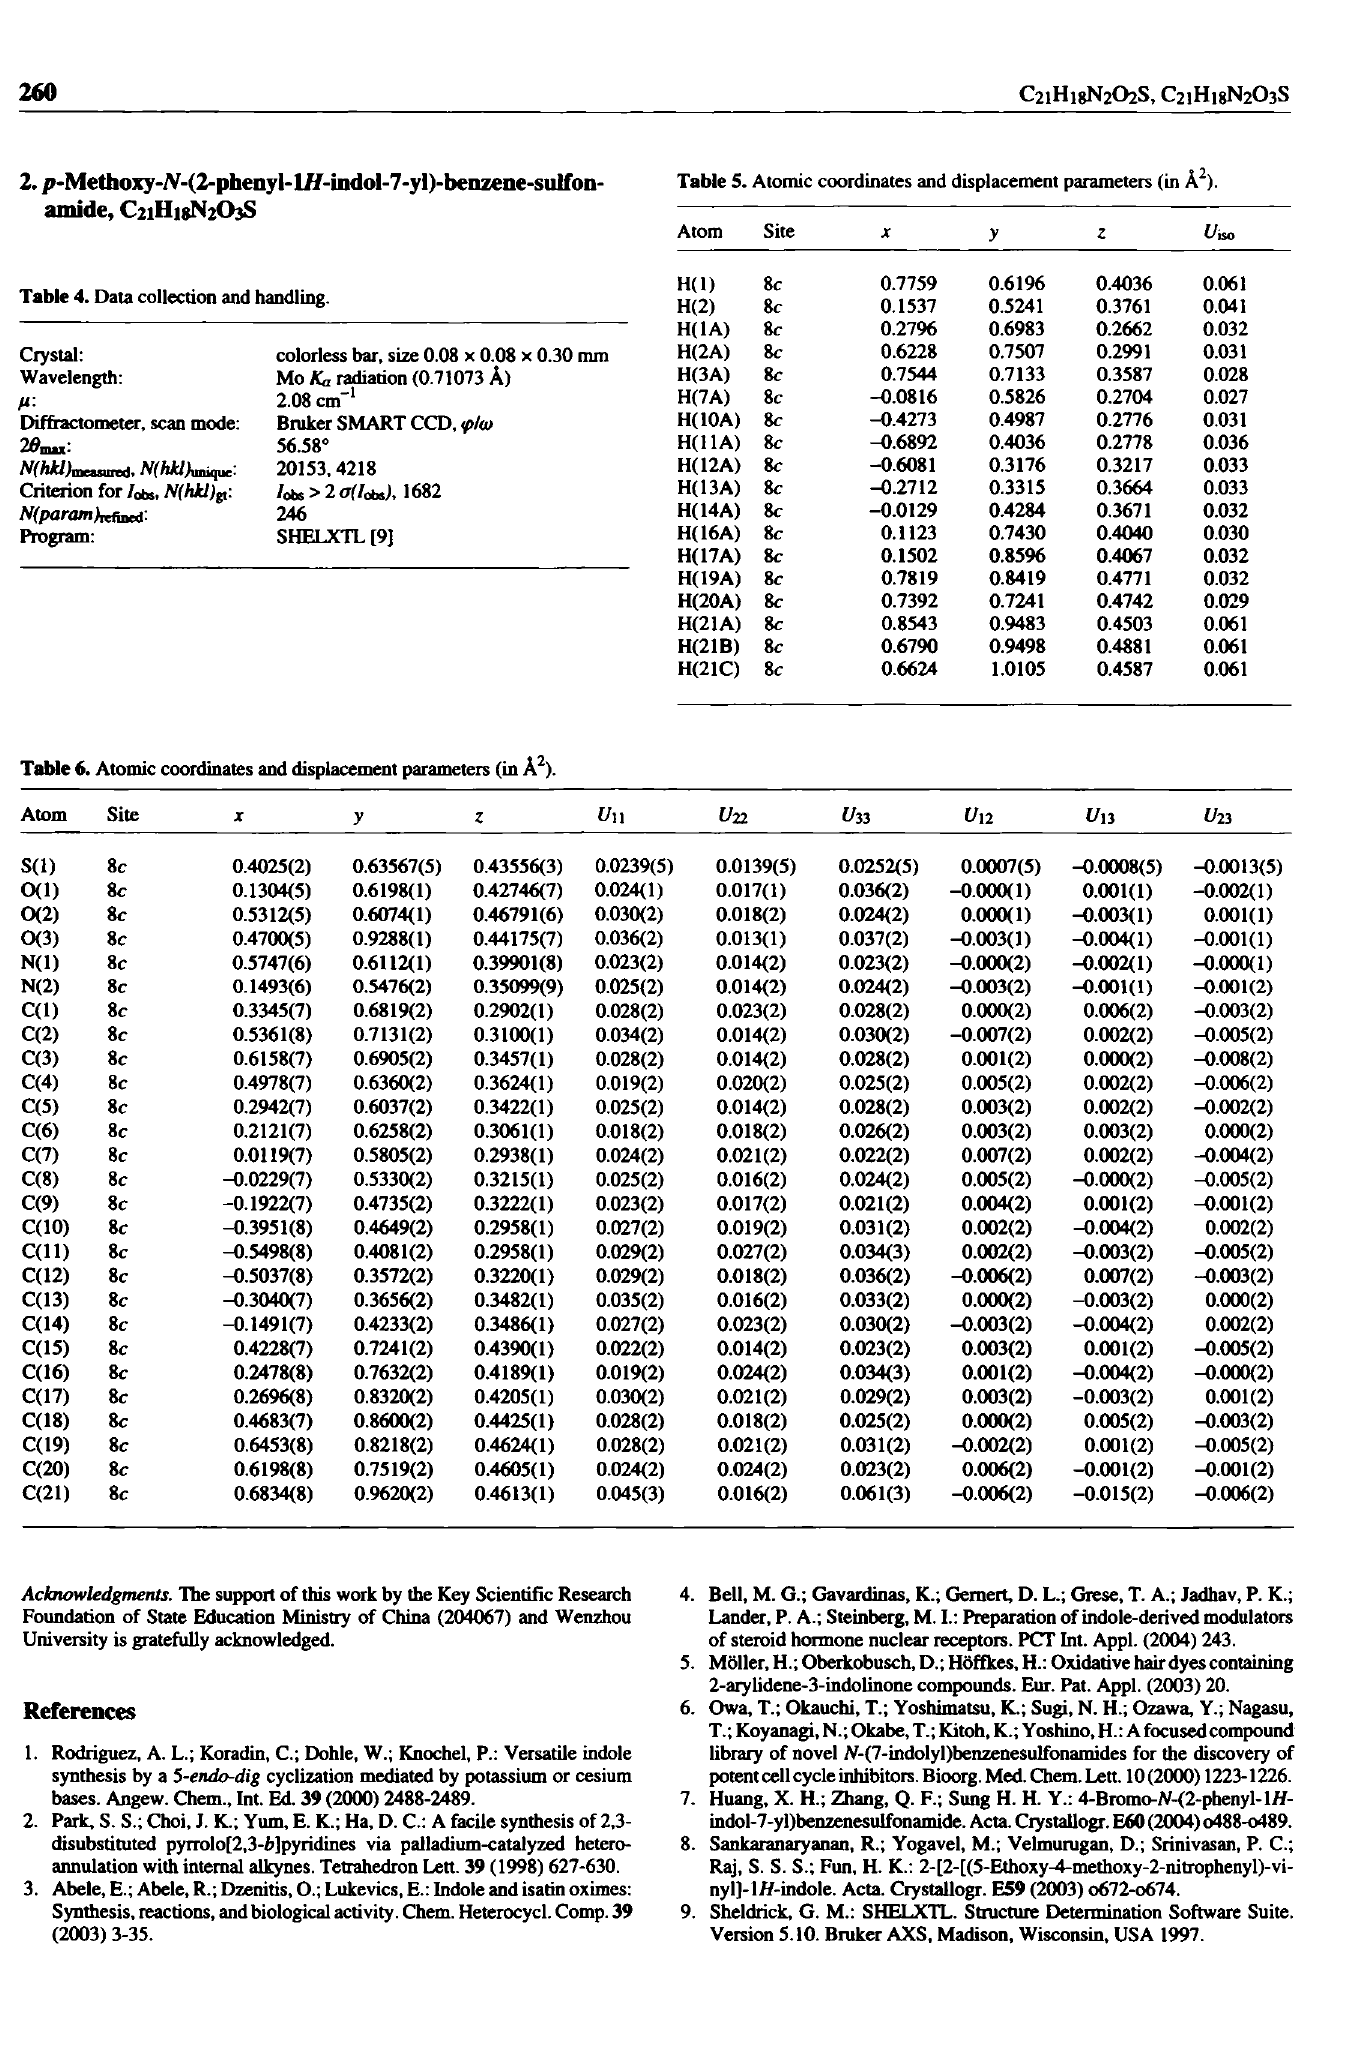
Table 4. Data collection and handling.